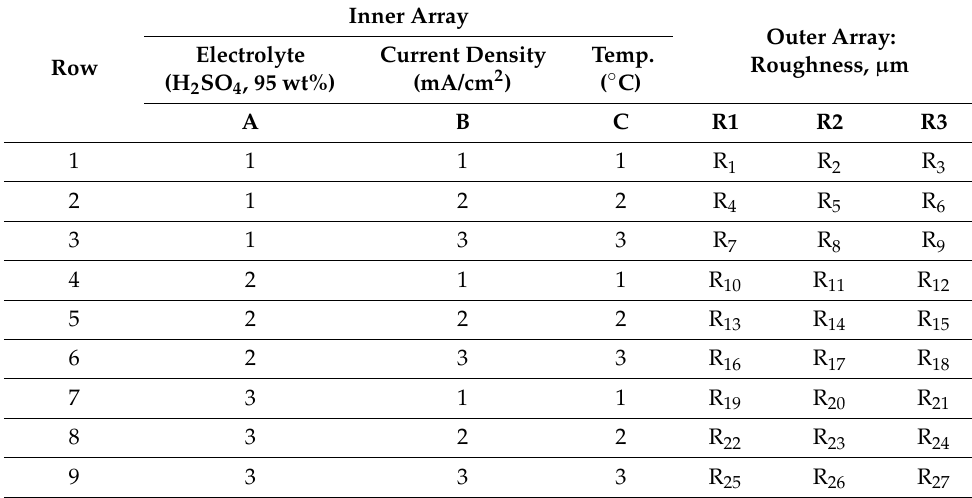
Table 3. Designed Taguchi orthogonal array of UNS N08367.